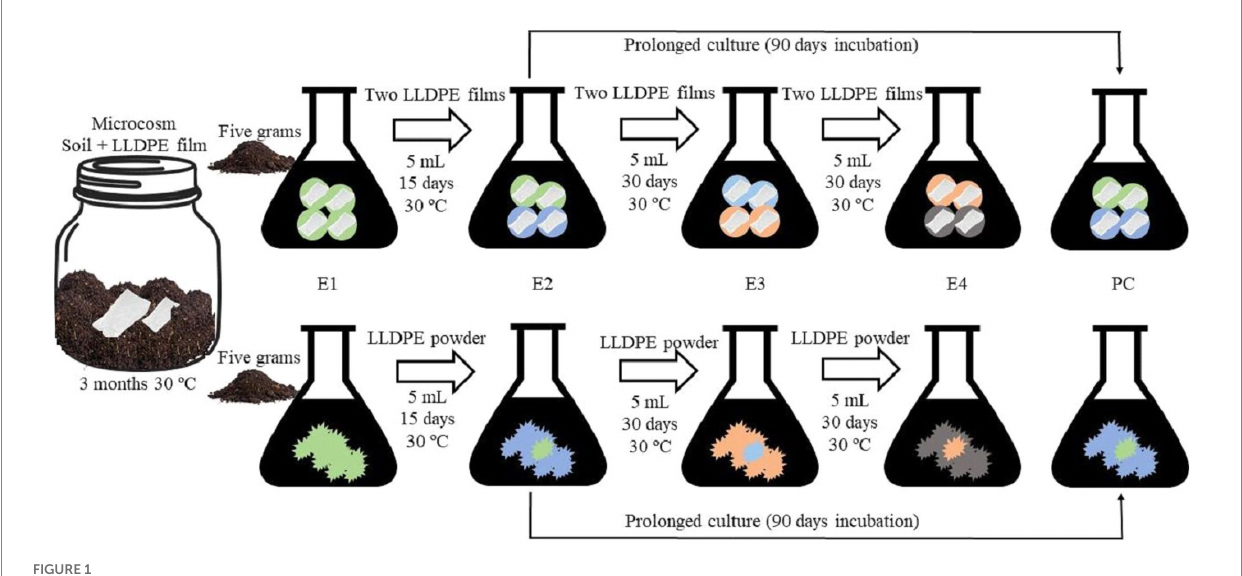
FIGURE 1 Experimental design. Sequential enrichments with plastic (film/powder) as the sole carbon source from a microcosm artificially contaminated with LLDPE. E1 was based on the transfer of 5 g of soil from the induced microcosm in two flasks with MSM and LLDPE (film or powder). The rest of the transfers included 5 mL of liquid medium and plastic (film or powder) from the previous enrichment culture to a fresh medium supplemented with sterile plastic (film or powder). E1, E2, E3, and E4: Enrichments 1, 2, 3, and 4. PC: Prolonged